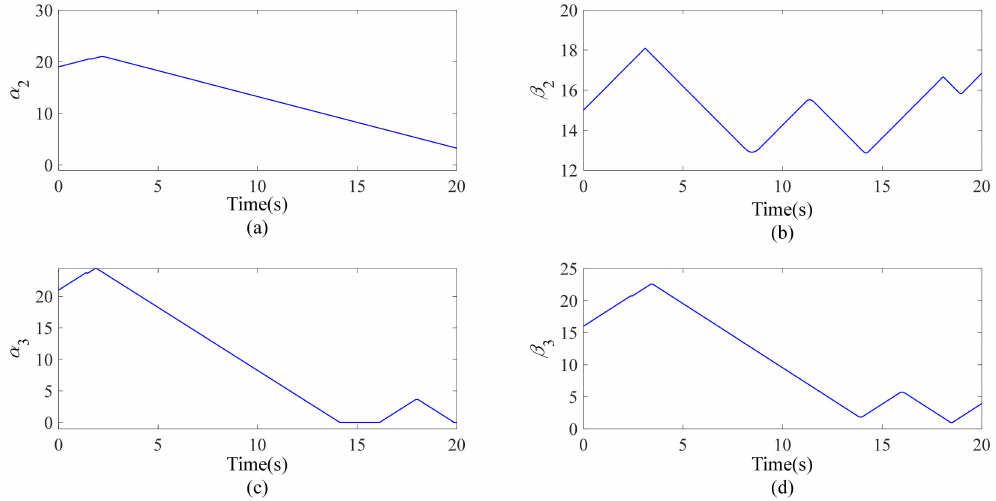
Figure 8. Adaptive gains of the two followers. ( a ) α 2 , ( b ) β 2 , ( c ) α 3 , ( d ) β 3